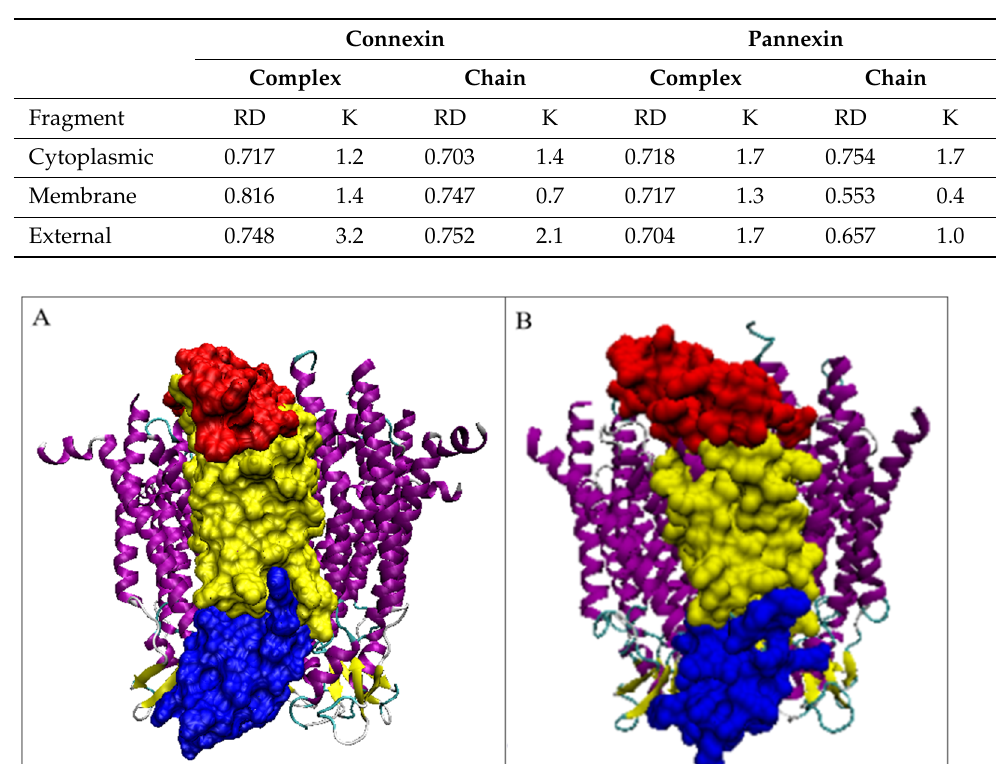
Table 3. The status of the complex part and the single chain is defined as cytoplasmic—the extra- membrane part facing the cytoplasm of the cell, membrane—part anchored to the membrane; external—the part exposed outside the cell.